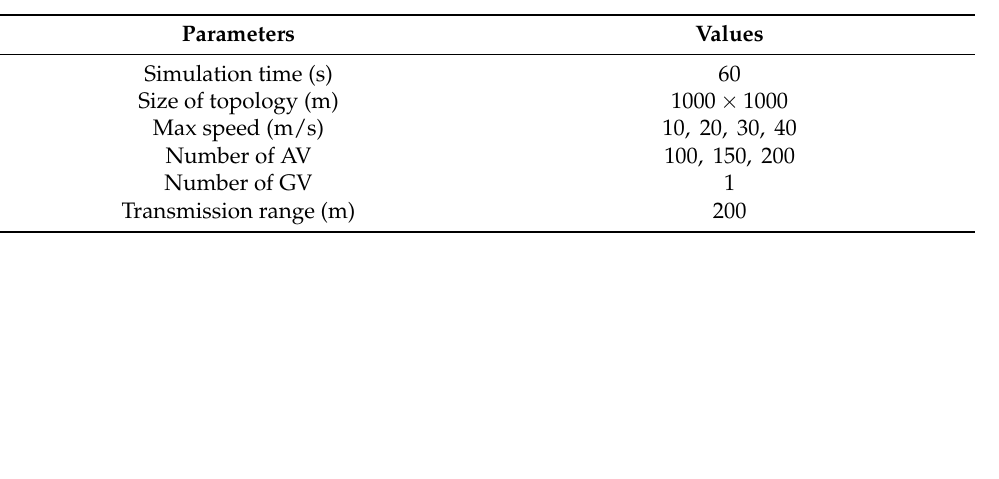
Table 3. The values of the simulation